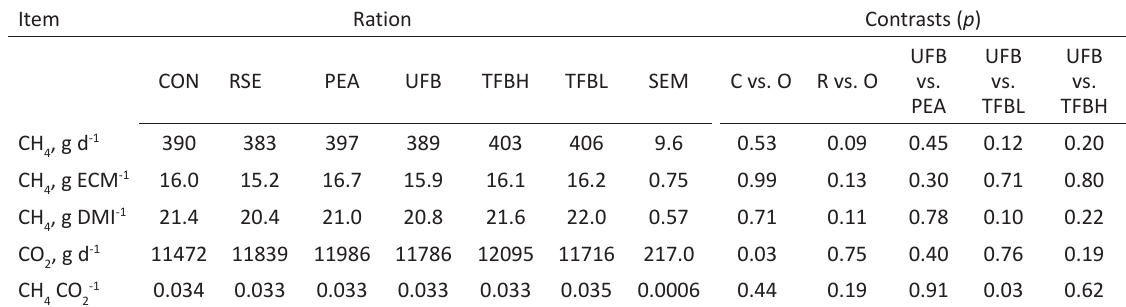
Table 5. Mean treatment effects on methane and carbon dioxide emission between diets Item Ration Contrasts ( p ) CON RSE